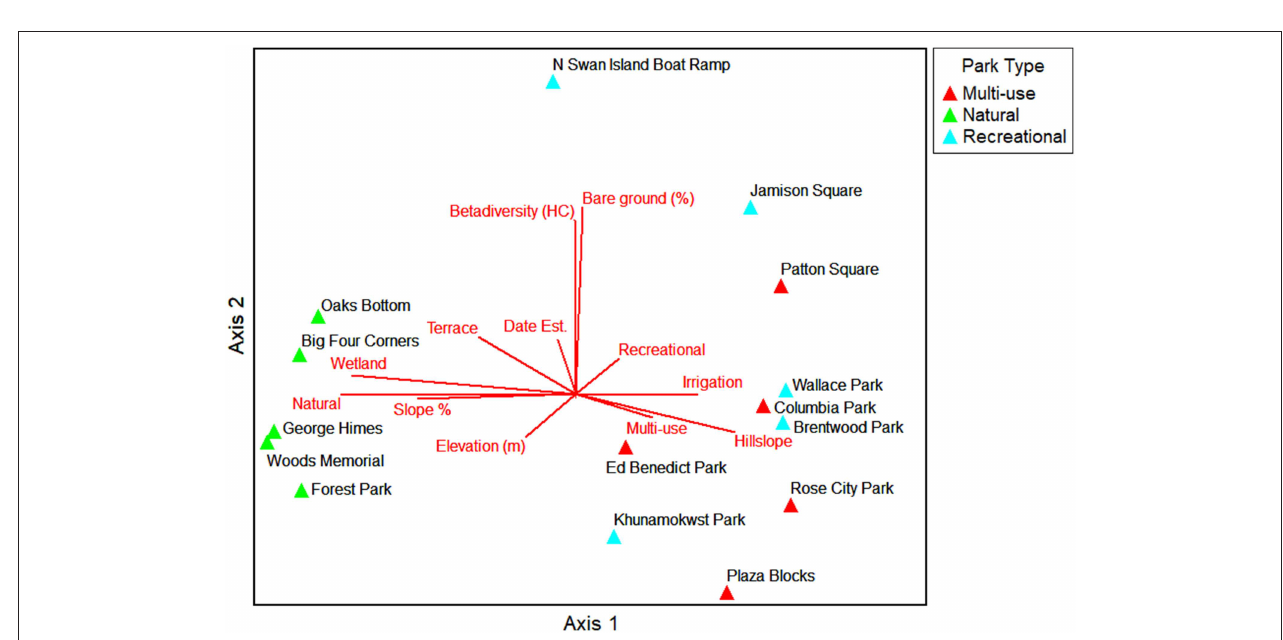
FIGURE 6 | NMS ordination Axes 1 and 2 for the parks in species space. Environmental variables that are strongly related to the individual ordination axes ( r 2 > 0.2) are shown as joint plots (radiated red